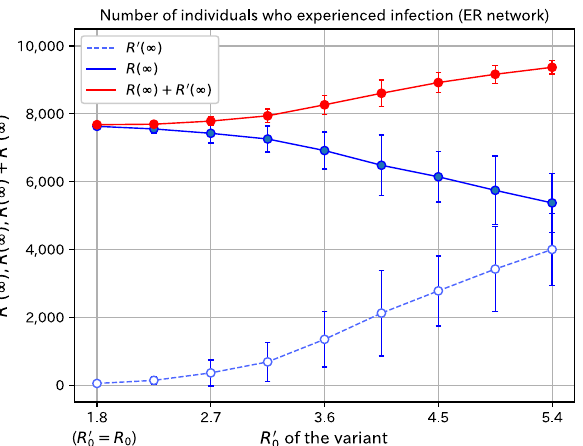
Figure 5. Dependence of the final number of infected individuals on R ′ 0 of the variant. The infectivity of the variant is the same as that of the original virus for R ′ 0 = 1.8